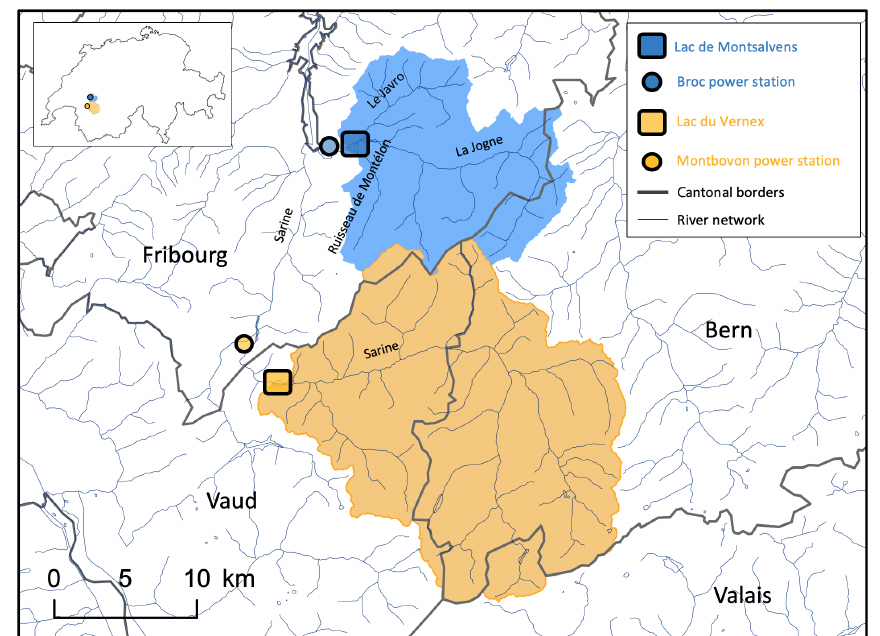
Figure 1. Map of the two study catchments: Montsalvens (blue) and Vernex (orange). The river network is shown in blue (dataset provided by the Swiss Federal Office for the Environment; FOEN); the cantons are labeled, and the dark gray lines depict the cantonal boundaries. The major river tributaries to the reservoirs are also labeled. The inset shows the location of the catchments within Switzerland. Table 1. Main characteristics of the two study catchments, including catchment area, elevation, glacier coverage, karst percentage, forest cover, and energy production. Data for this table were derived from multiple sources: the area and mean elevation of the catchment were provided by Groupe E and were confirmed during delineation for modeling purposes, glacier coverage was estimated using satellite imagery from Google, karst hydrogeology was estimated using a dataset provided by Bitterli et al. (2004), and mean energy production was provided by the Swiss Federal Office of Energy (SFOE). Reservoir, dam Area Mean elevation coverage